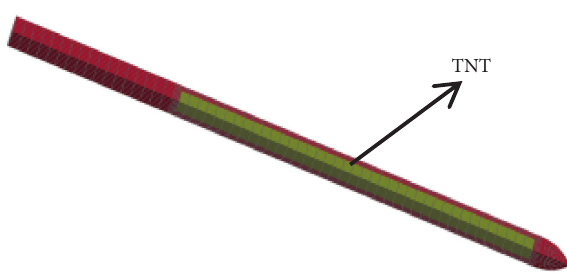
Figure 3: Simplified model of earth penetrator of reinforcement